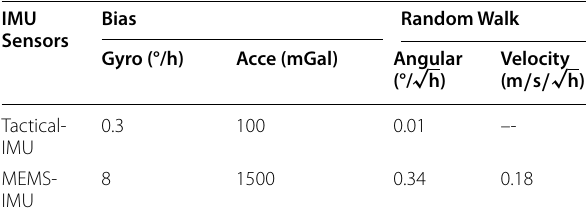
Table 3 Technical specifications of the IMU sensors in the experimental platform